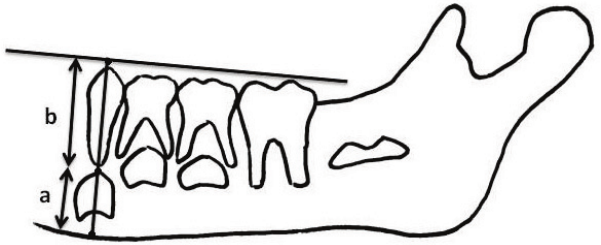
Figure 2. Calculating the eruption percentage for canines and first Table 2. Number of samples in each age and sex group (36 cases and 36 controls).